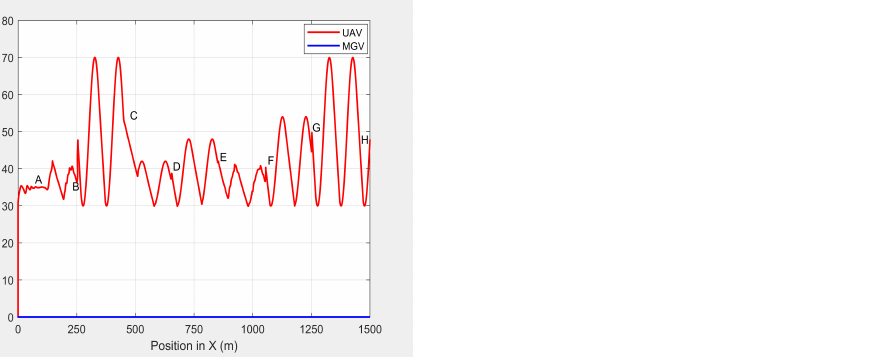
Figure 15. The 2D plot of the UAV’s altitude and position when following the MGV while moving at a varying velocity.